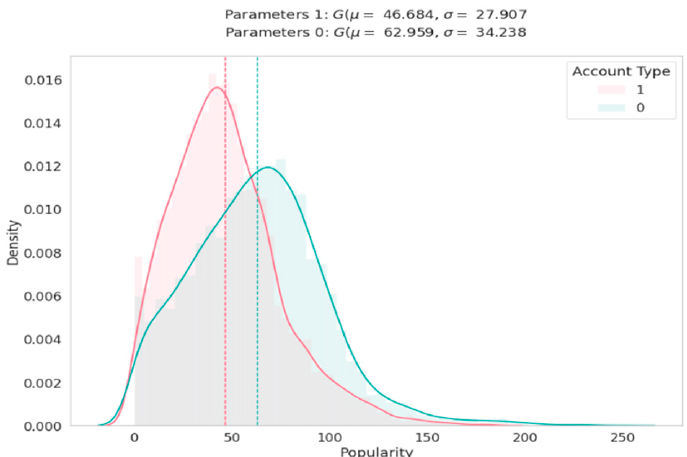
Figure 3. Distribution of the popularity of bots (class = 1) and humans (class = 0) in TwiBot-20. Table 2. List of extracted profile features and their description.